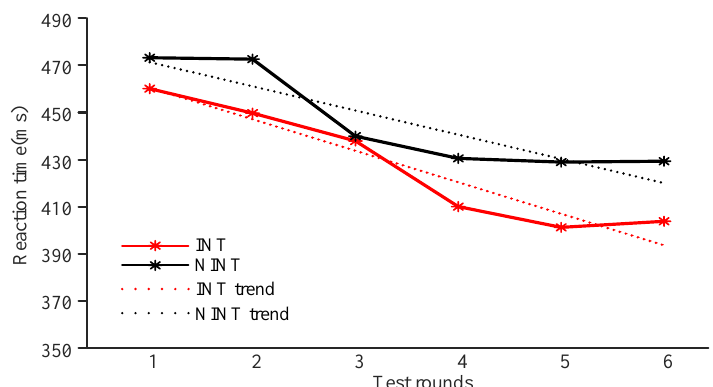
Figure 9. Changes of ANT reaction time in two